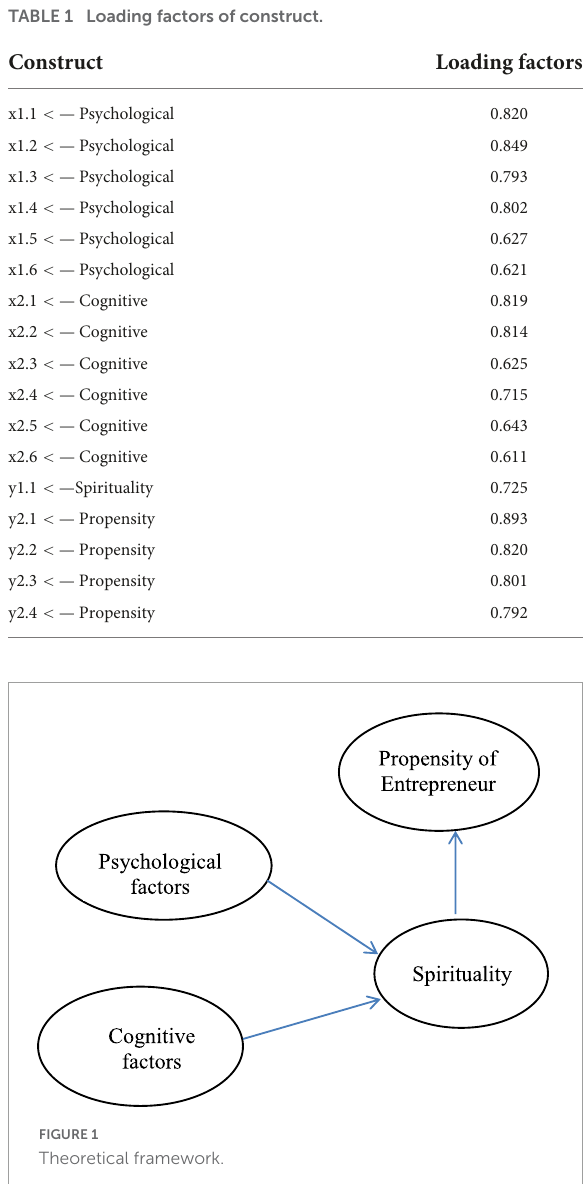
SEM needs a small value for Chi-square statistic ( χ 2) and probability (P) smaller than 0.05 and other